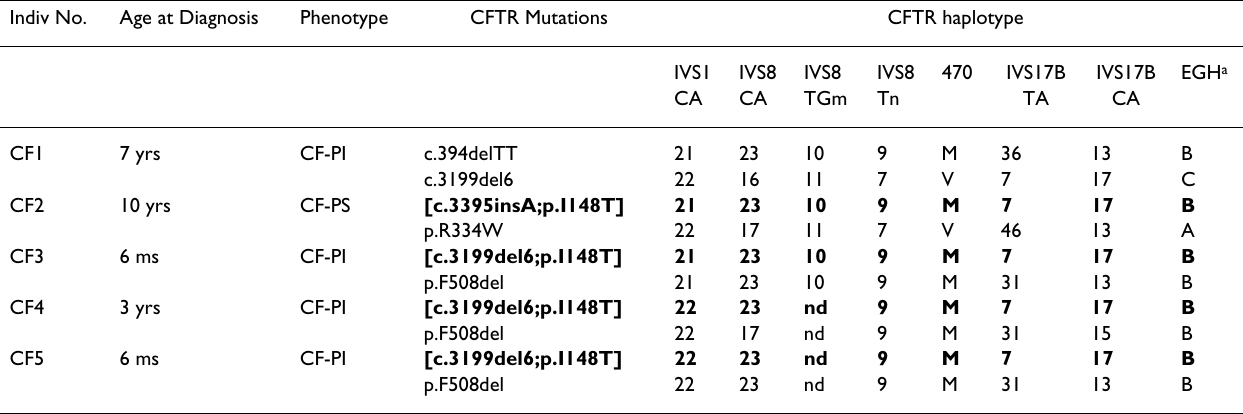
Table 1: CFTR haplotypes associated with mutations found in CF patients carrying p.I148T in cis with c.3395insA or c.3199del6 and in one CF patient carrying c.3199del6 alone Indiv